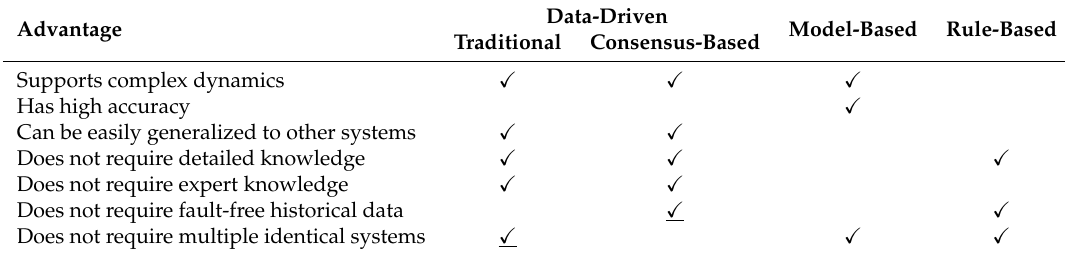
Table 1. Advantages of FDD methods. Consensus-based methods have similar advantages and disadvantages to traditional data-driven methods. Their respective trade-offs, underlined in the table, are the requirements for multiple identical systems, and the requirement for fault-free historical